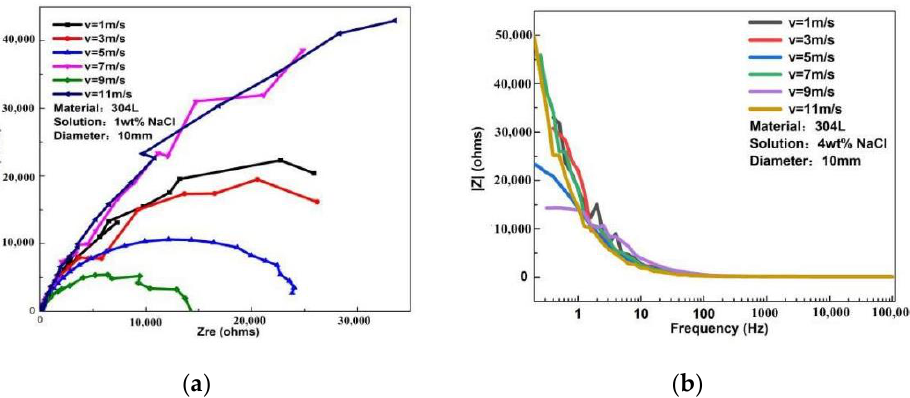
Figure 11. Electrochemical impedance spectrum of 304L stainless steel at different flow velocities. ( a ) Nyquist diagram of electrochemical impedance spectrum of 304L stainless steel at different flow velocities. ( b ) Bode diagram of electrochemical impedance spectrum of 304L stainless steel at different flow velocities.